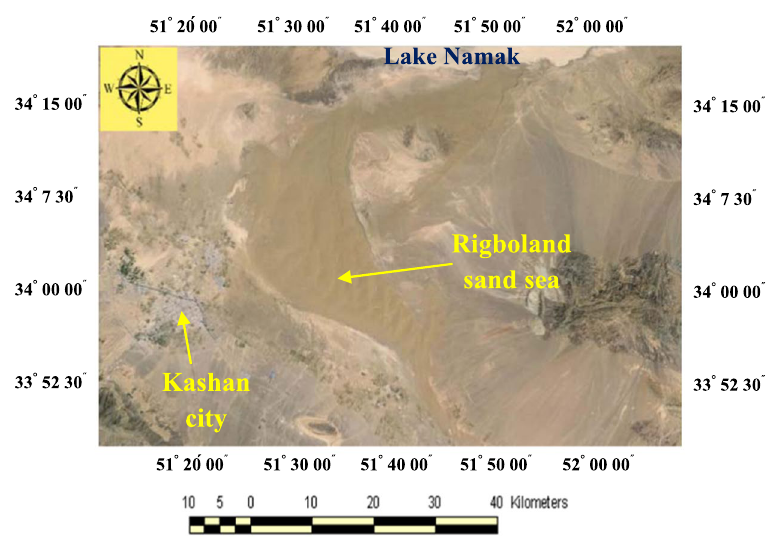
Figure 2. The confines of Rigboland sand sea with brown color in centre of Iran (ENVI software version